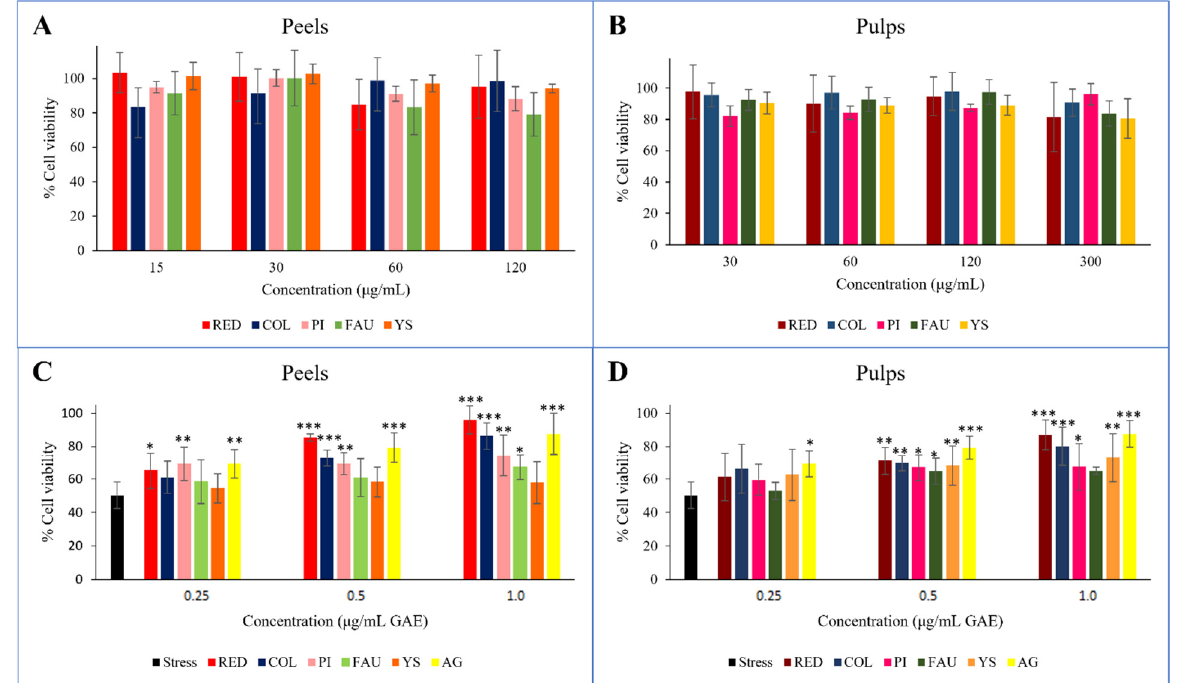
Figure 3. In vitro cell evaluation of the Balb/3T3 cell line. Cytotoxicity screening after 2-h treatments with peel ( A ) and pulp ( B ) extracts. Protective effects of peel ( C ) and pulp ( D ) extracts from H 2 O 2 -induced oxidative stress, reported as cell viability % after 2-h treatments with 1500 µ M H 2 O 2 of pre-treated Balb/3T3 cells. H 2 O 2 = stressed control; C = Collette; F = Faustrime ; GA = gallic acid; PI = Pink Ice; R = Red; YS = Yellow Sunshine; *** = p value < 0.0001; ** = p value < 0.005; * = p value < 0.05 vs. stress.